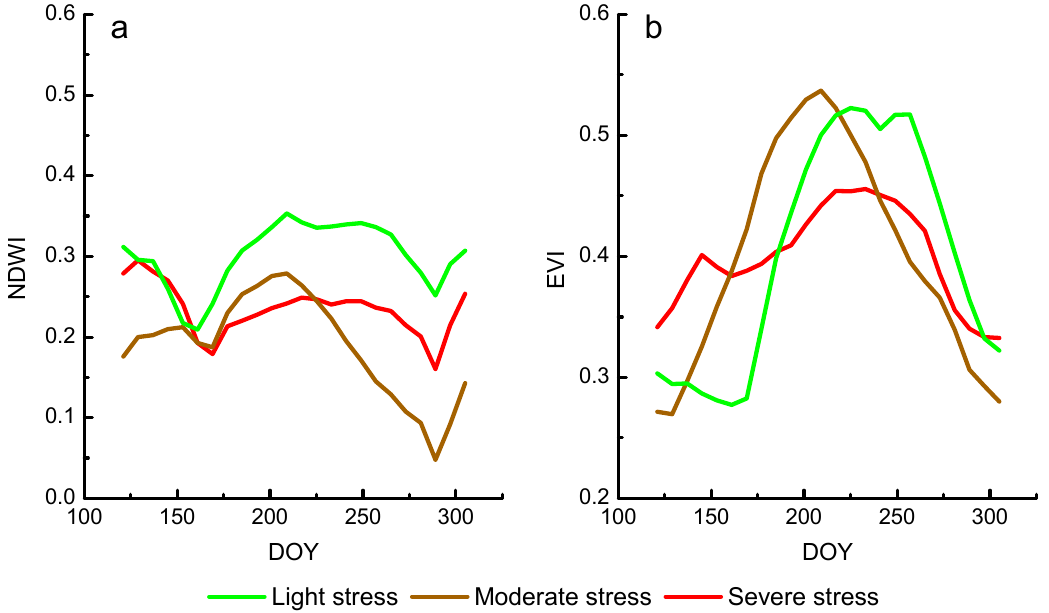
Figure 4. The NDWI ( a ) and EVI ( b ) temporal profiles after smoothing .